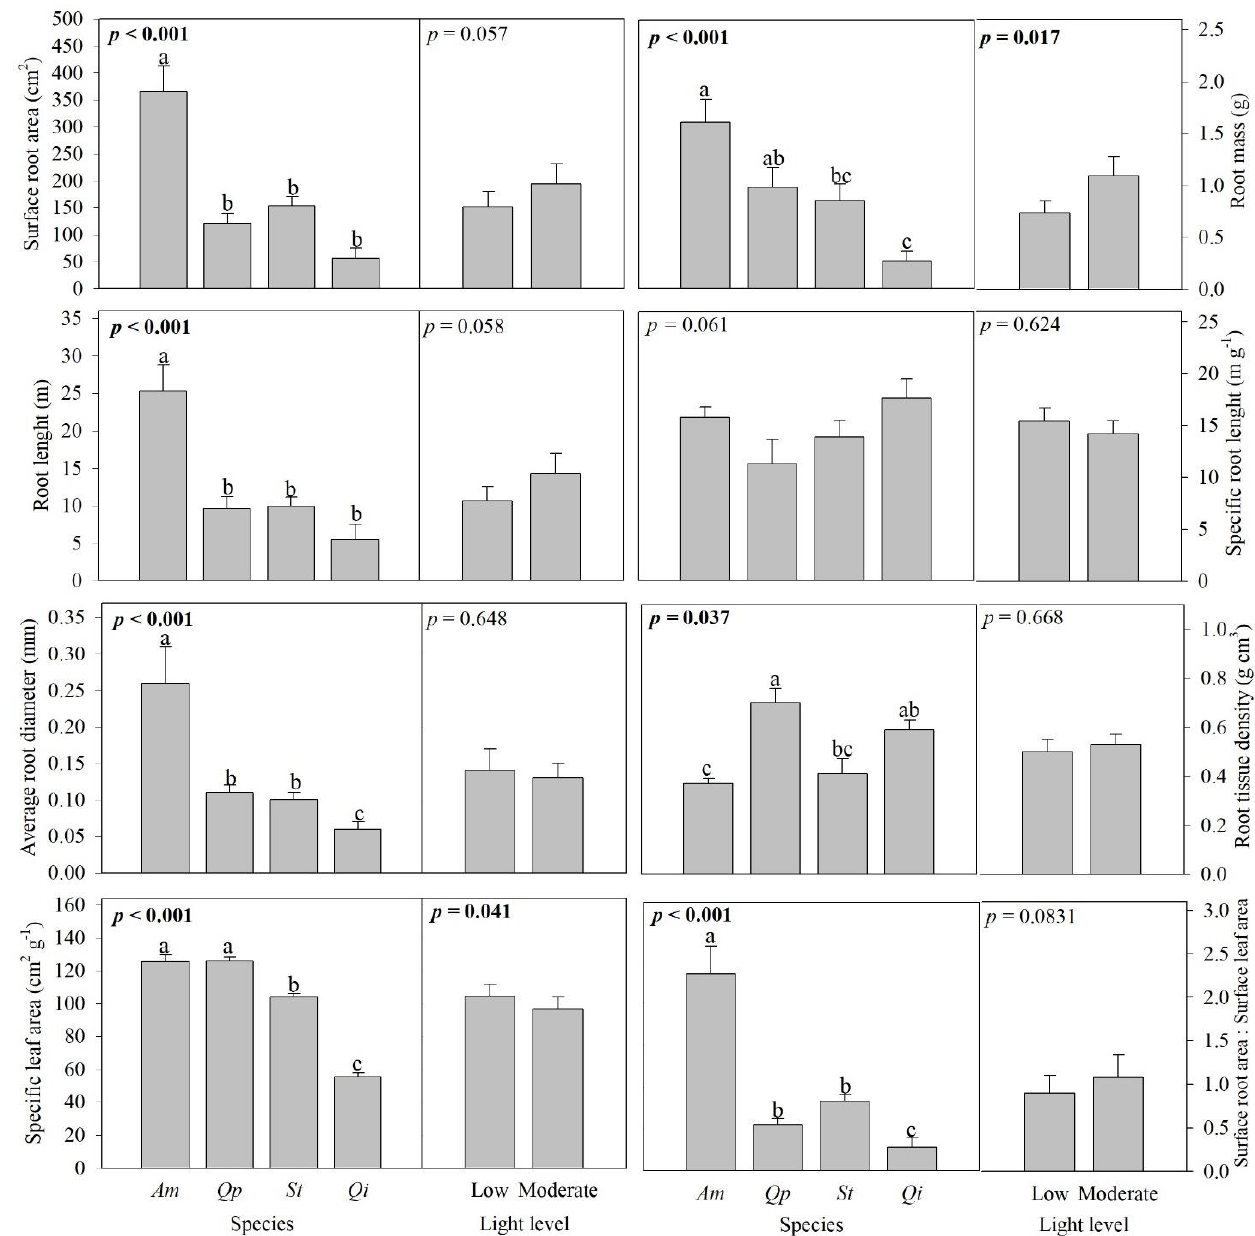
Figure 4. Morphology or structure of protruding roots and leaf variables of four broadleaf Mediterranean tree species grown under two light levels: low (irradiance of 17%) and moderate (irradiance 33%). Data are mean ± one SE. p -values of the main effects are given in each subplot. Means not sharing common letters are significantly different after Tukey HSD test, α = 0.05. Am : Acer monspessulanum , Qp : Quercus pyrenaica , St : Sorbus torminalis , Qi : Quercus ilex.